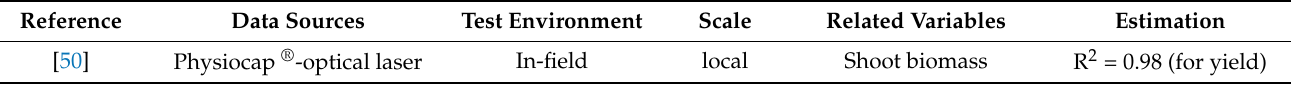
Table 7. Summary of records included in the systematic review (F—data-driven models based on laser data processing).